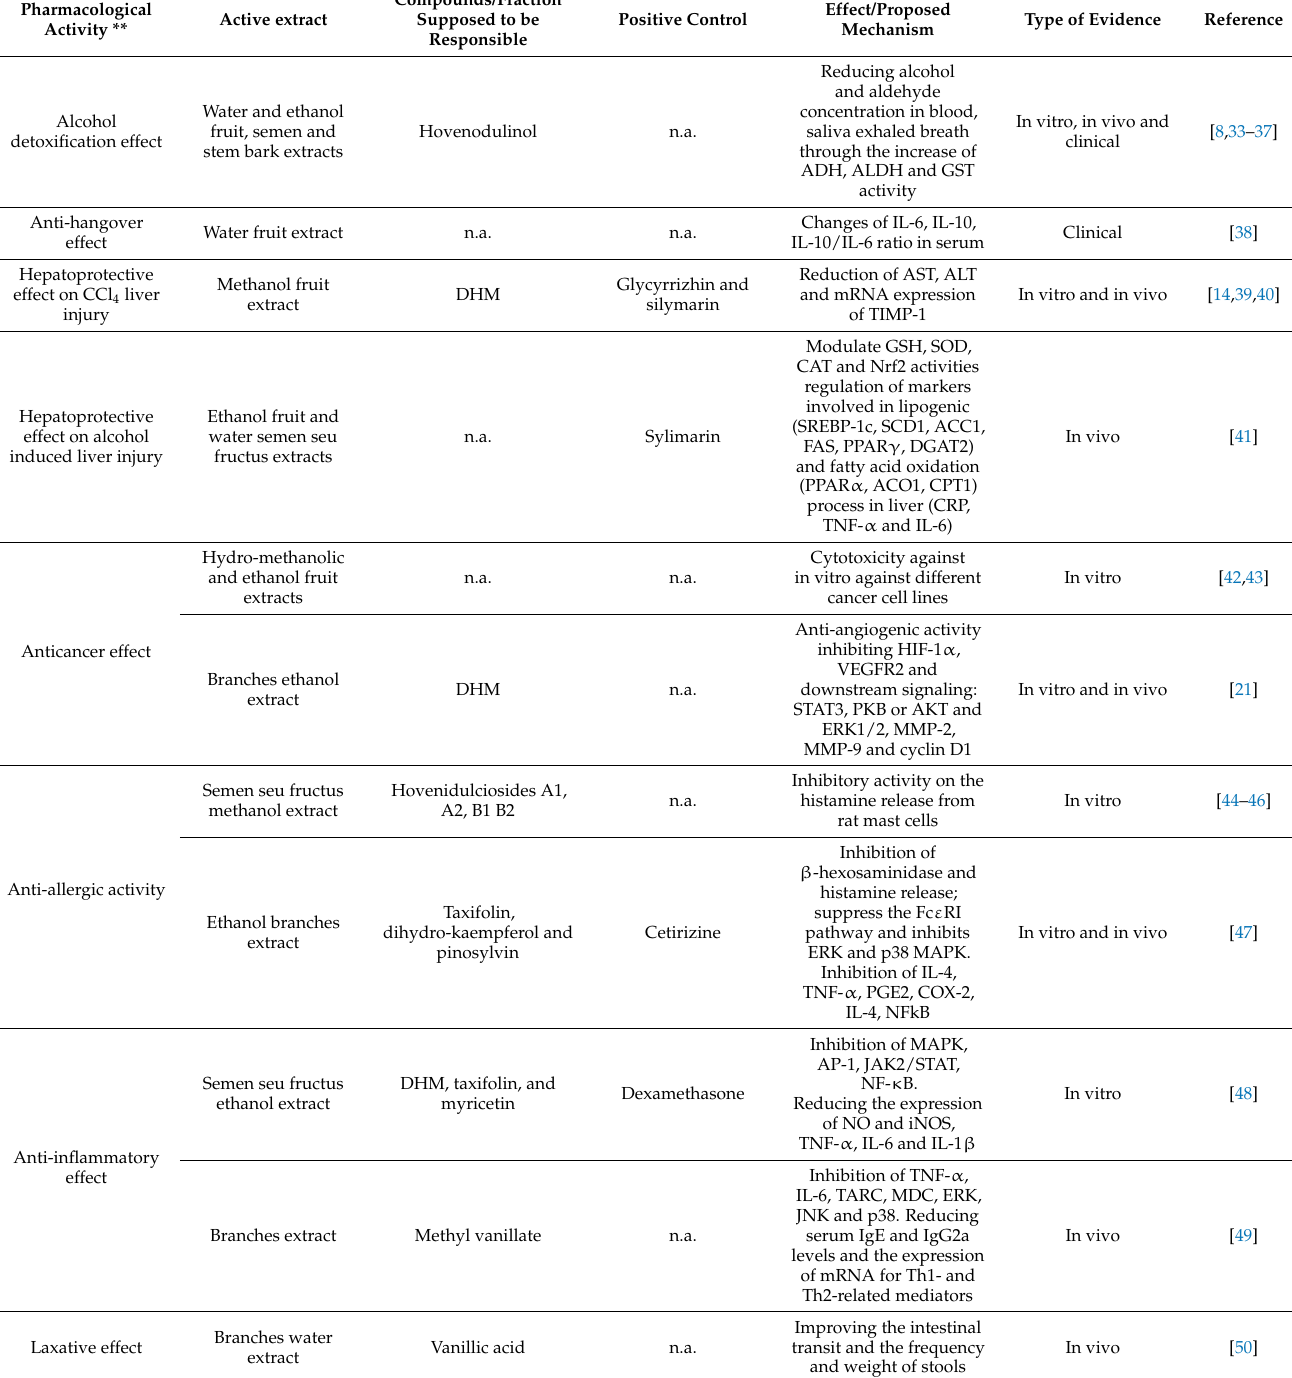
Table 2. Summary of H. dulcis pharmacological